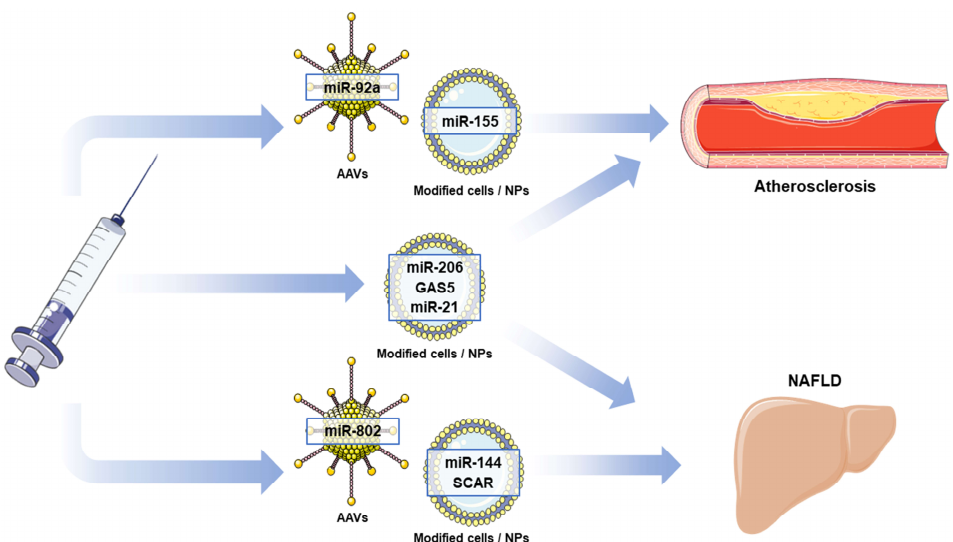
Figure 4. Potential ncRNAs that can be used as therapeutic targets for the modulation of oxidative stress in atherosclerosis and NAFLD. AAVs: adeno-associated viruses; NPs: nanoparticles; NAFLD: non-alcoholic fatty liver disease. This figure has been edited from Servier Medical Art. Servier is